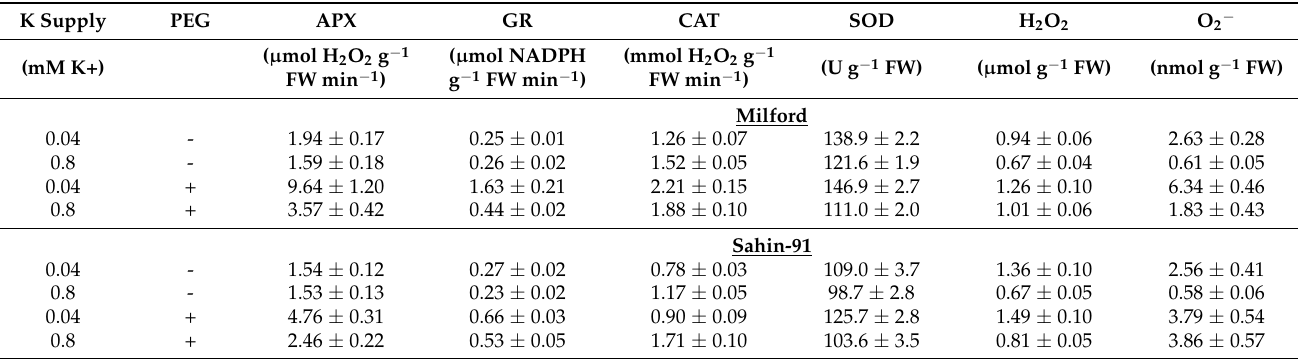
Table 2. Antioxidant activities (APX, GR, CAT, SOD) and the concentrations of reactive oxygen species (H 2 O 2 , O 2 − ) in fully expanded young leaves of two barley cultivars (Milford and Sahin-91) grown in the nutrient solution under low (0.04 mM K+) and adequate (0.8 mM K+) K supply without ( − PEG) and with (+PEG) PEG-induced water deficit. Means of samples taken between 11 and 19 DAO ± SE are shown ( n = 18).